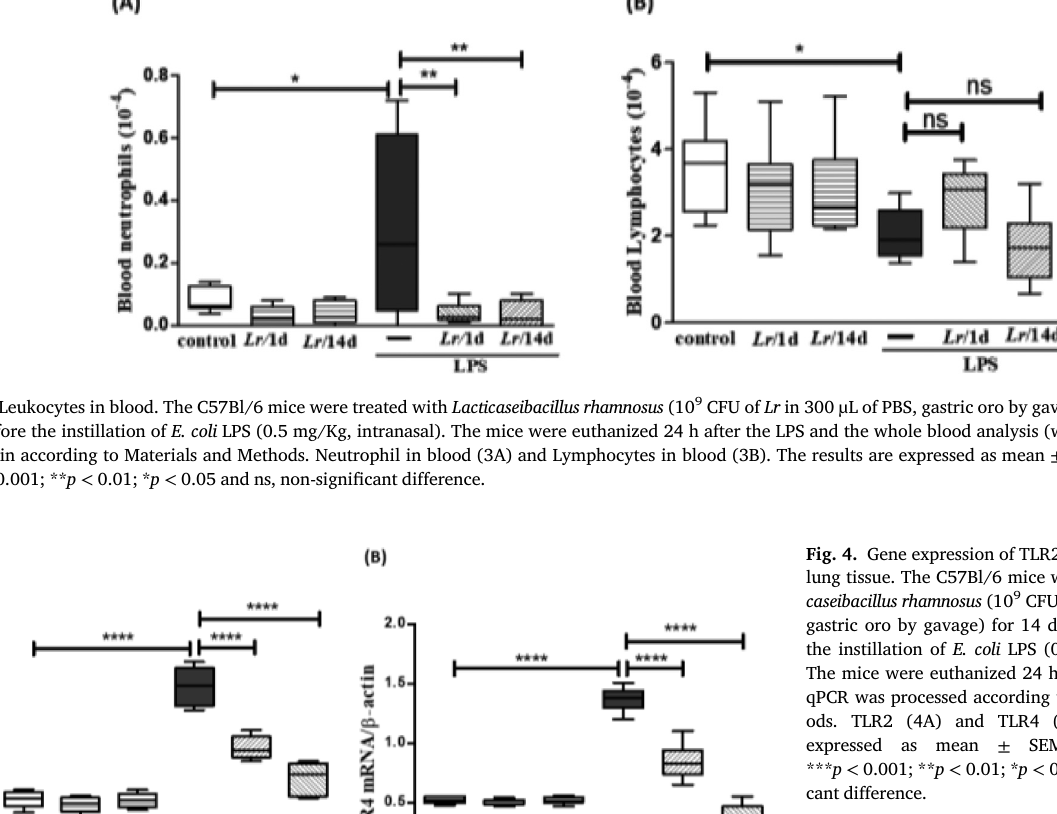
Fig. 4. Gene expression of TLR2 and TLR4 receptors in lung tissue. The C57Bl/6 mice were treated with Lacti- caseibacillus rhamnosus (10 9 CFU of Lr in 300 µ L of PBS, gastric oro by gavage) for 14 days or one day, before the instillation of E. coli LPS (0.5 mg/Kg, intranasal). The mice were euthanized 24 h after the LPS, and the qPCR was processed according to Materials and Meth- ods. TLR2 (4A) and TLR4 (4B). The results are expressed as mean ± SEM **** p < 0.0001; *** p < 0.001; ** p < 0.01; * p < 0.05 and ns: non-signi fi - cant